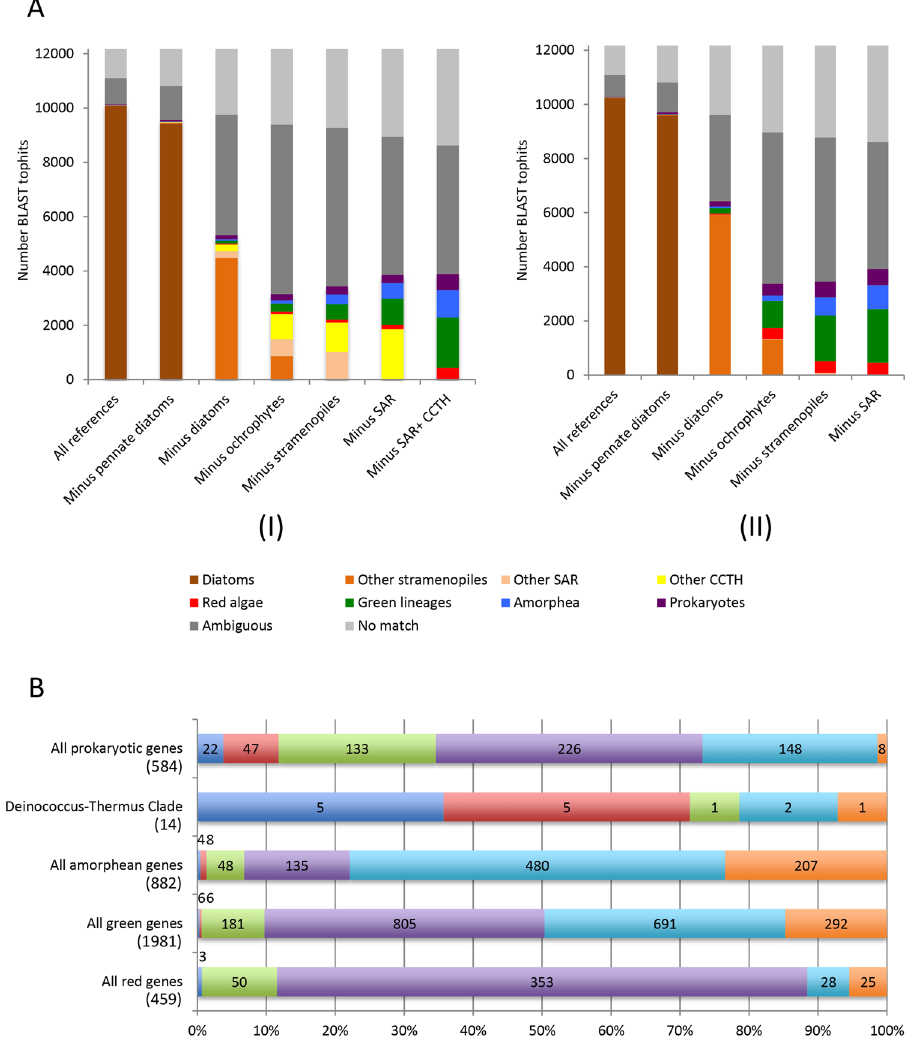
Figure 2. BLAST top hit analysis of P. tricornutum genes. ( A ) Comparison of the number of genes of unambiguous taxonomic origin, identified by BLAST top hit analysis of the complete Phatr3 protein annotations against six different reference libraries, constructed using UniRef, jgi genomes and other transcriptome libraries, and six different patterns of taxon inclusion: a library containing all sequences from the tree of life; all sequences except those from pennate diatoms; all except those from diatoms; all except those from stramenopiles; all except those from SAR clade members; and all except those from SAR and CCTH clade members. The right-hand graph (II) shows similar values calculated for reference libraries from which all algae with a suspected history of secondary endosymbiosis other than ochrophytes were removed. Note that in this case a separate value for a reference library excluding SAR and CCTH clade taxa is not provided, as all it is not known when secondary endosymbioses arose within CCTH clade lineages 21 , hence all CCTH clade taxa were excluded from the analysis. ( B ) Comparison of the proportion of genes that yield top hits against five different categories (all prokaryotes, the Deinococcus-Thermus clade only, all red algae, and green groups, and all amorphea) following the removal of different groups from the complex algae-free dataset. Total number of genes within each category is indicated beneath it in round brackets. Data labels for each value are provided in the corresponding segment; where the segment is too small to accommodate the corresponding value, the value is placed outside the chart, and shaded to match the color of the segment. The largest value recorded for each gene category corresponds to the most probable evolutionary time point at which genes were acquired; for example, the largest number of genes of red algal affinity were recovered following the removal of all algae with plastids of secondary or higher endosymbiotic derivation from the reference dataset, indicating a large-scale donation of red algal genes into algae with plastids of secondary or higher endosymbiotic